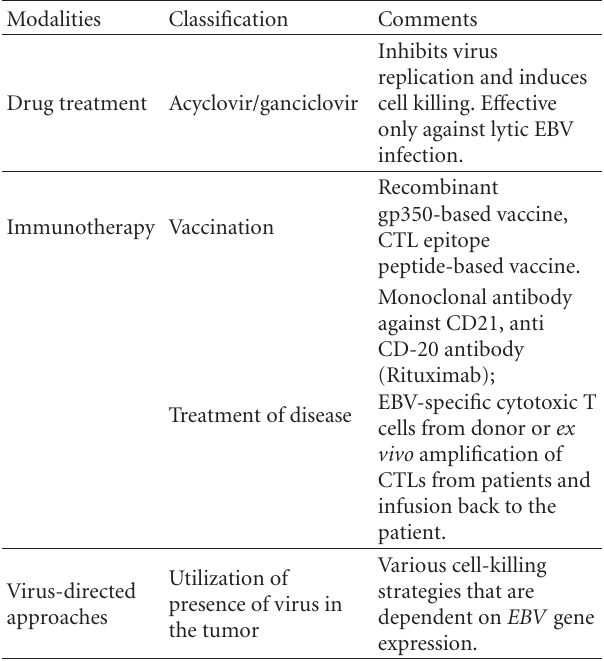
Table 1: Available therapies for EBV